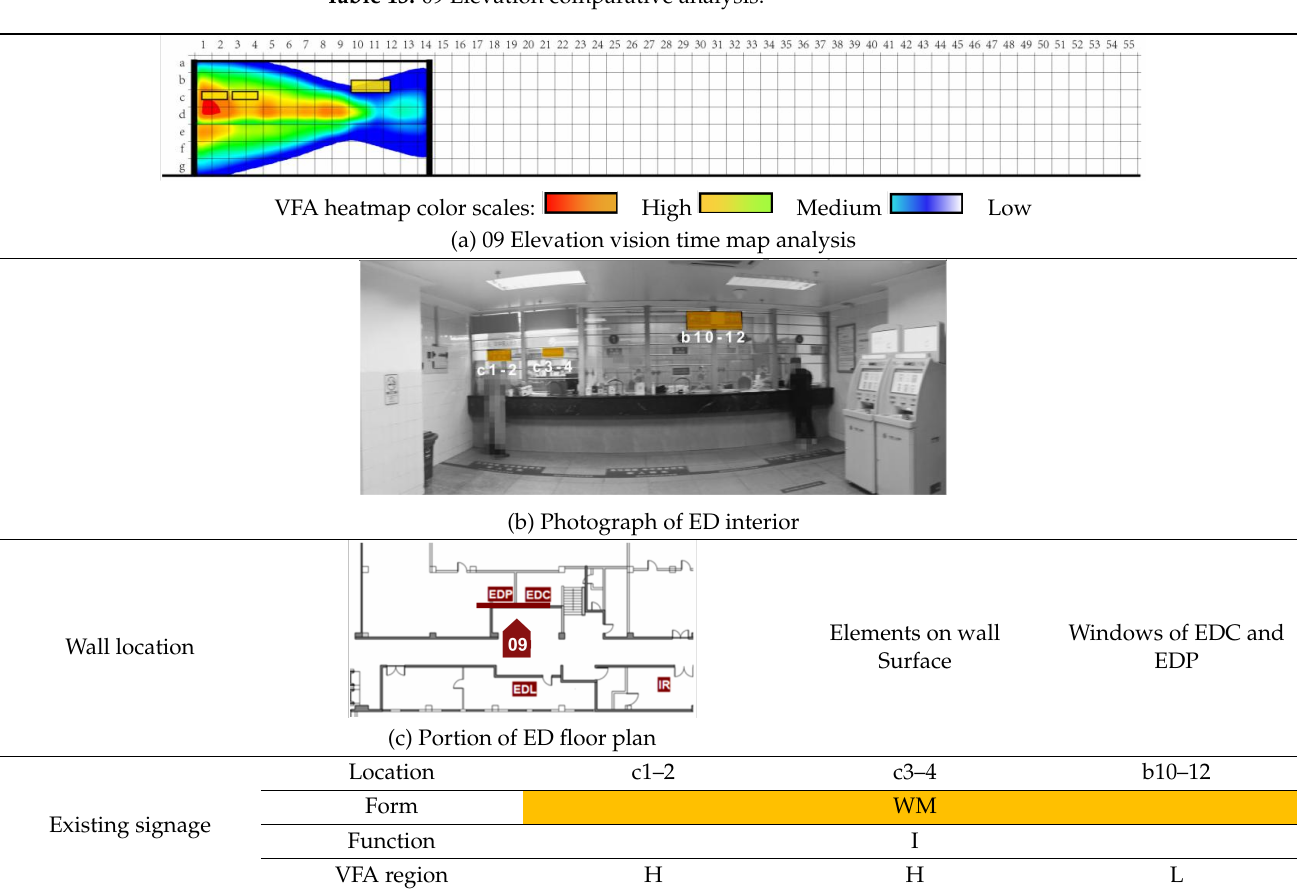
Table 13. 09 Elevation comparative analysis.